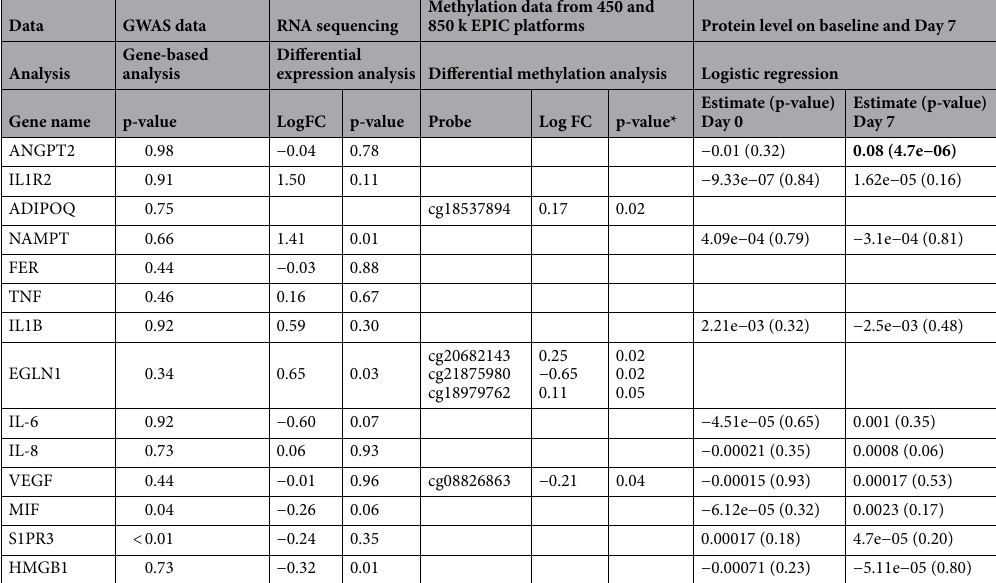
Table 2. Summary of the results from the candidate gene analysis. GWAS genome-wide association study, Chr chromosome, LogFC log of the fold change. Bold: significant after corrected for multiple comparisons. *Only reported the methylation results with raw p-values <